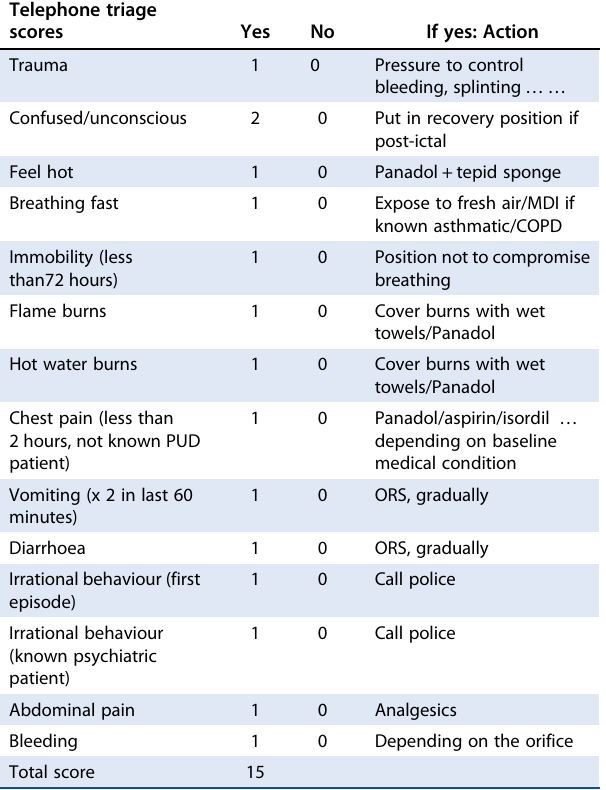
Table 2: Telephone triage scores and possible action Telephone triage scores